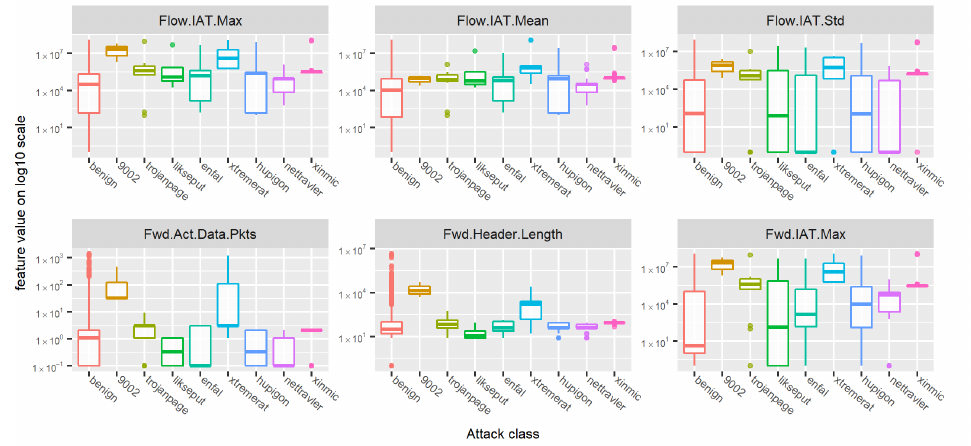
Figure 6. Boxplots for different features—part 2.